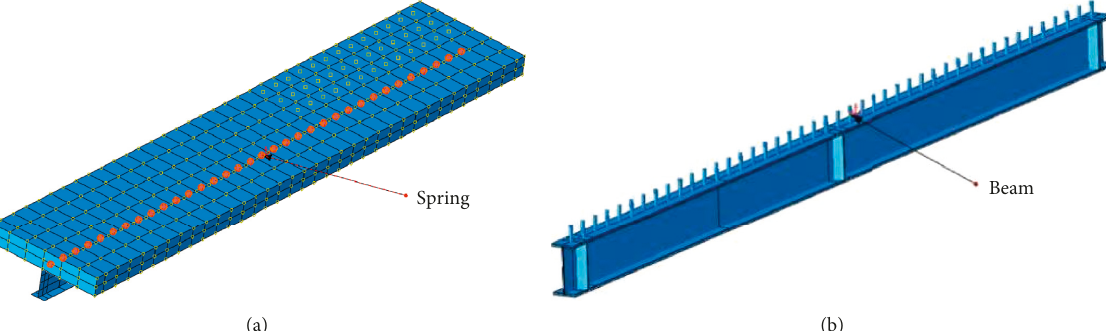
Figure 8: Simplified FE models for steel-concrete composite beams. (a) Spring elements for studs and (b) beam elements for studs.